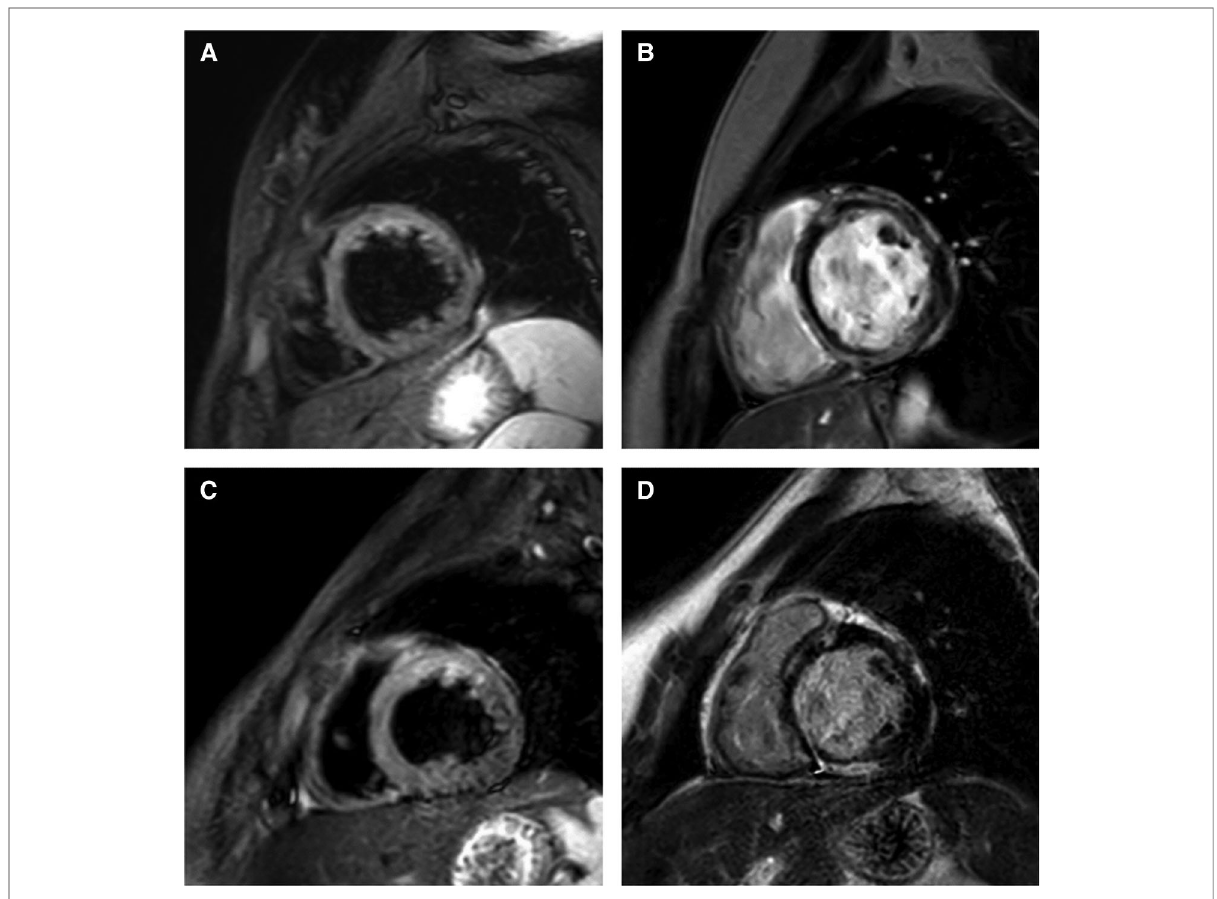
FIGURE 2 Short-axis cardiac magnetic resonance imaging on days 2 ( A,B ) and 18 ( C,D ) after the patient ’ s presentation. ( A ) High signal intensity in anterior wall of left ventricle on T2-weighted image. ( B ) Diffuse multifocal patchy late gadolinium enhancement (LGE). ( C ) Sustained high signal intensity in anterior wall of left ventricle on T2-weighted image. ( D ) Persistent multifocal patchy